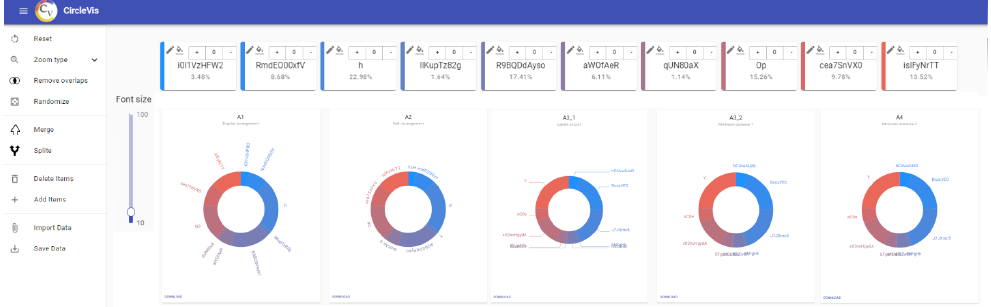
Figure 13. CircleVis visualization: five circles with random datasets and various arrangements: A 1. angular arrangement; A 2, path arrangement; A 3 L , list arrangement; A 3 Ln , linear arrangement; A 4, our proposed